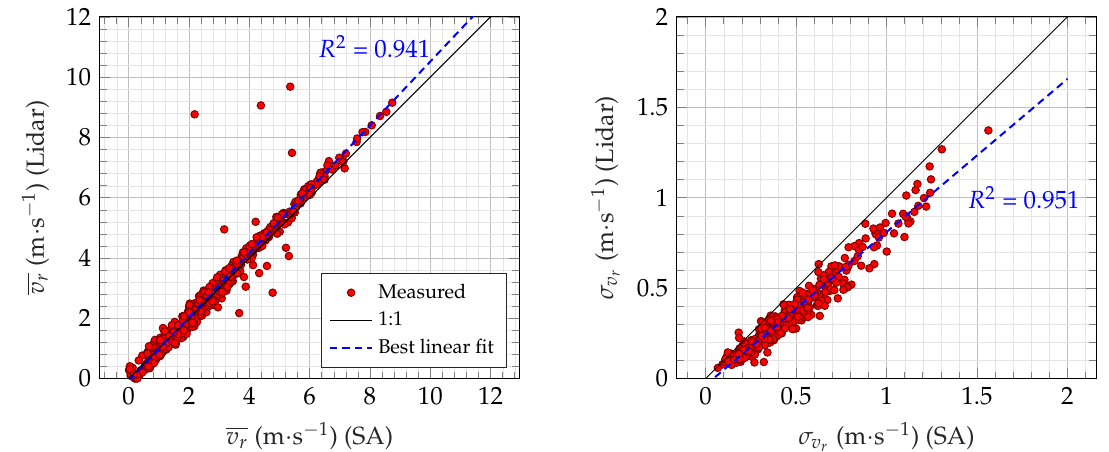
Figure 6. Ten-minute averaged mean velocity ( left ) and standard deviation ( right ) of the along-beam component recorded by LW2 (vertical axis) and the sonic anemometer (horizontal axis), at z = 83m, during the last four days of the measurement